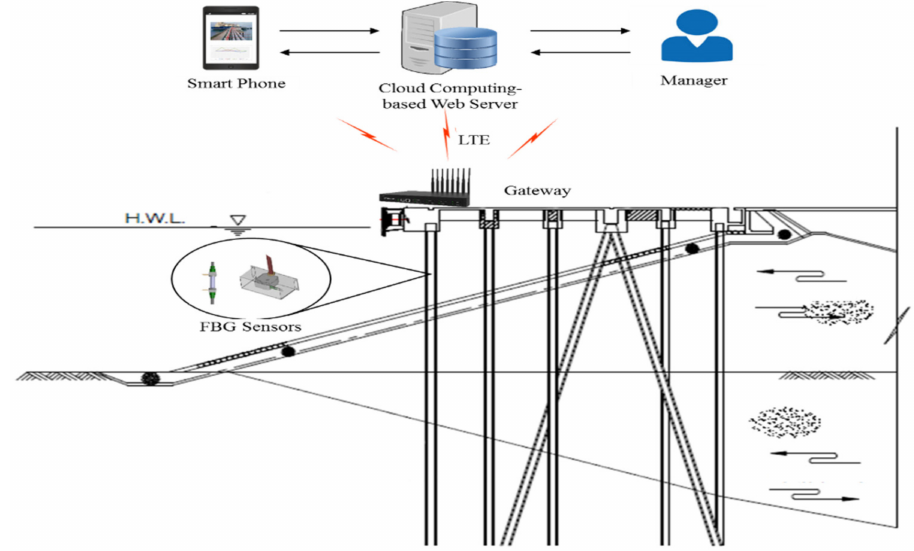
Figure 9. The cloud computing-based pier type port structure stability evaluation platform configuration